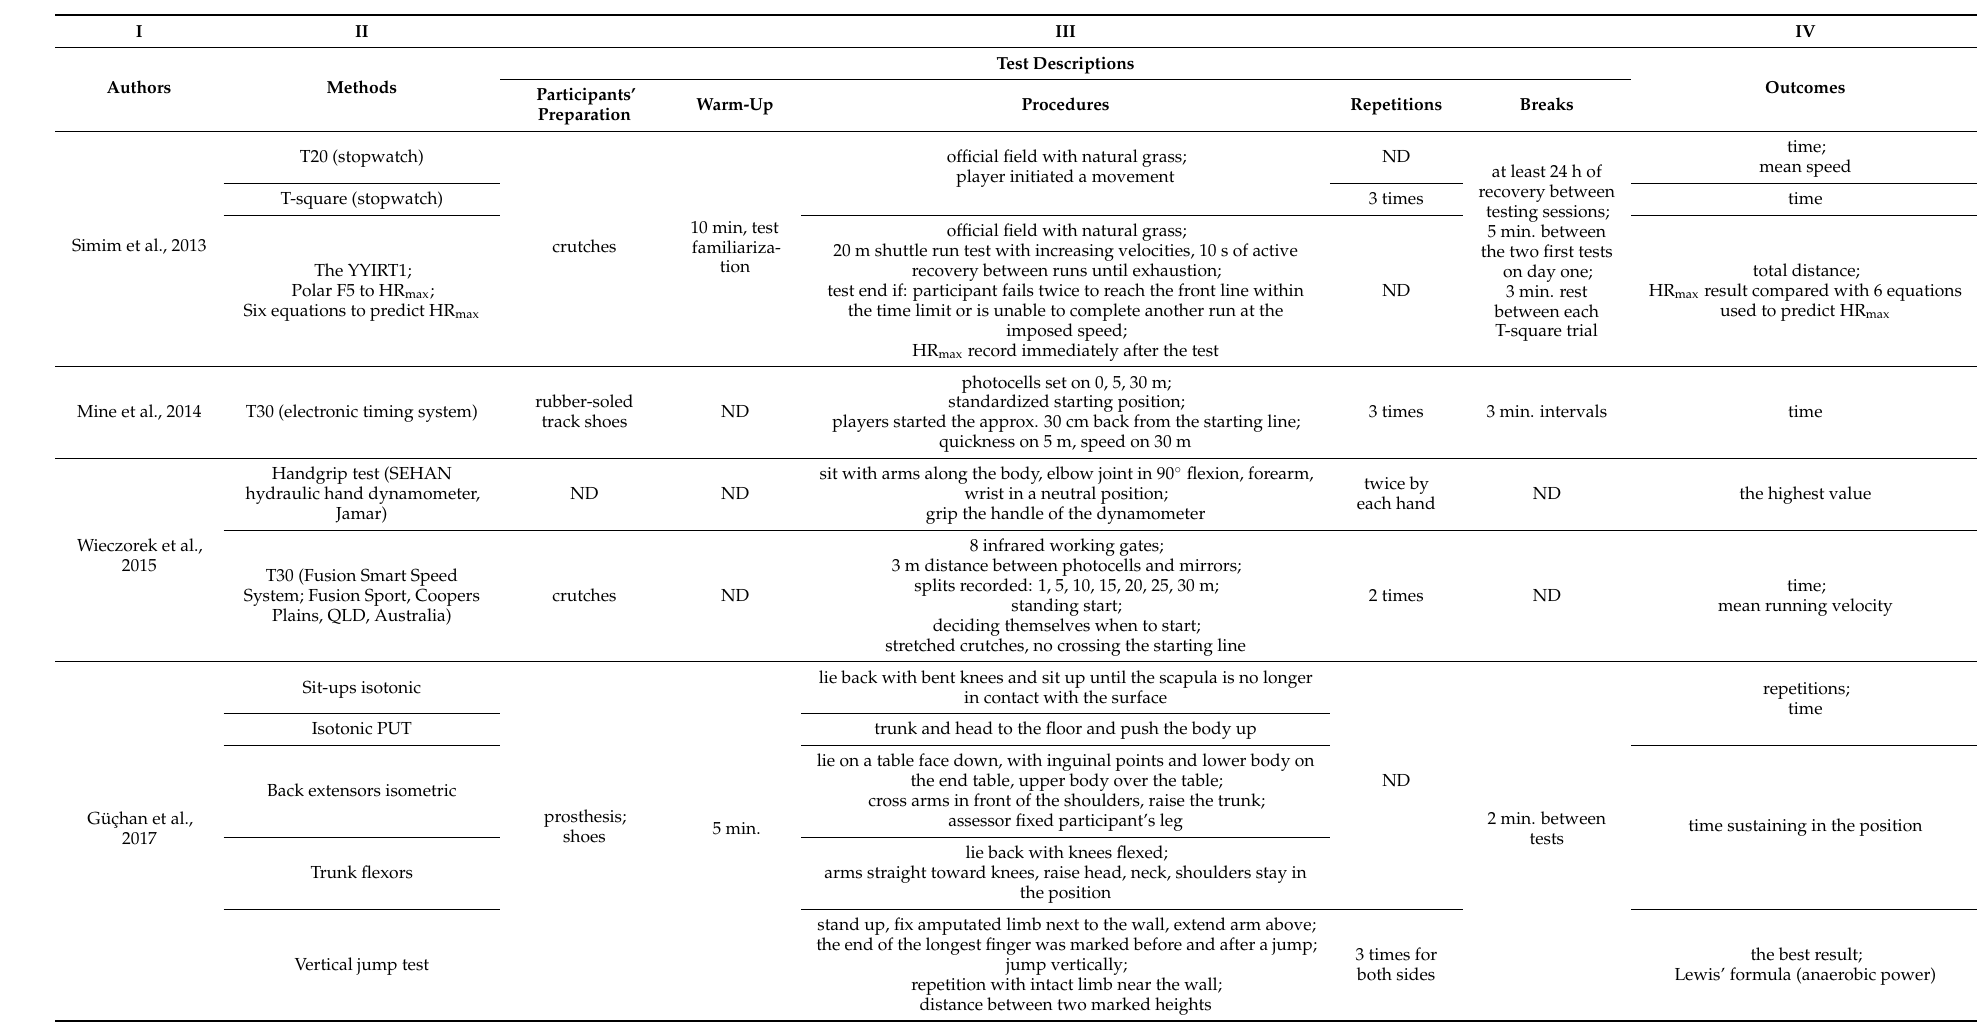
lie on a table face down, with inguinal points and lower body on the end table, upper body over the